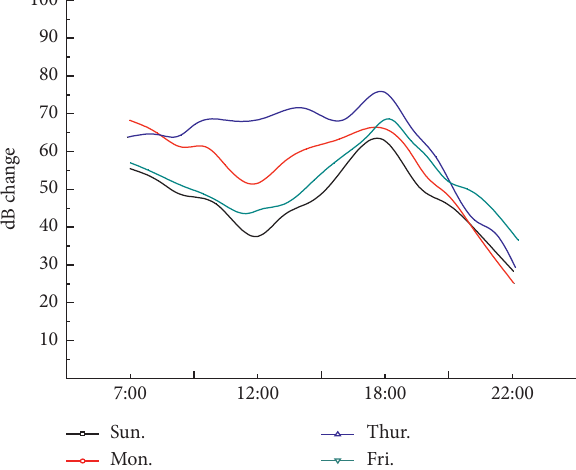
Figure 7: Variation trend in the noise